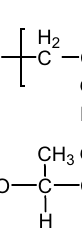
Figure 4: FTIR of ( a ) PVA, ( b ) PVA/PLA ( PVA 90 wt% ) , ( c ) PVA/PLA ( PVA 70 wt% ) , and ( d ) PLA. Figure 5: Schematic of the hydrogen bonding between PVA and